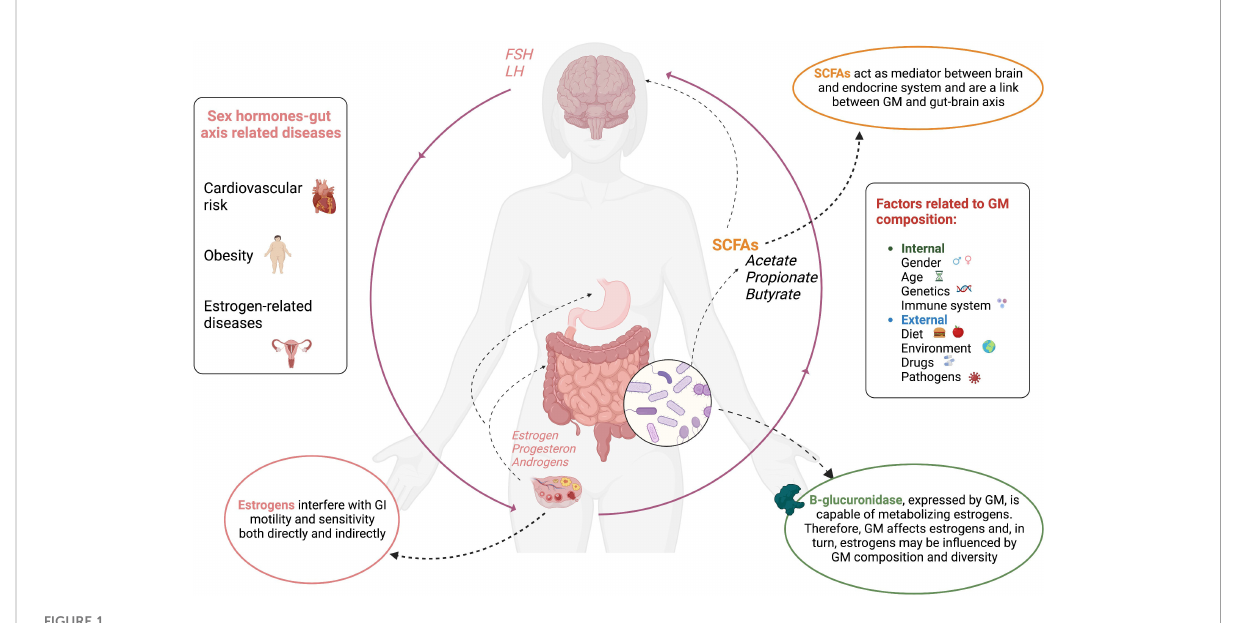
FIGURE 1 Interconnections between sex hormone and gut